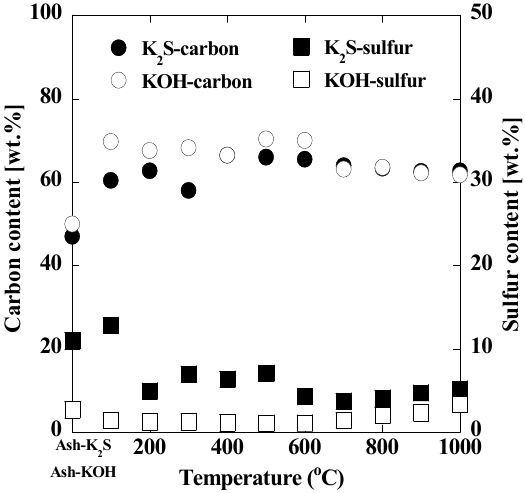
Figure 5. Contents of carbon and sulfur of products pyrolyzed at various pyrolysis temperatures.